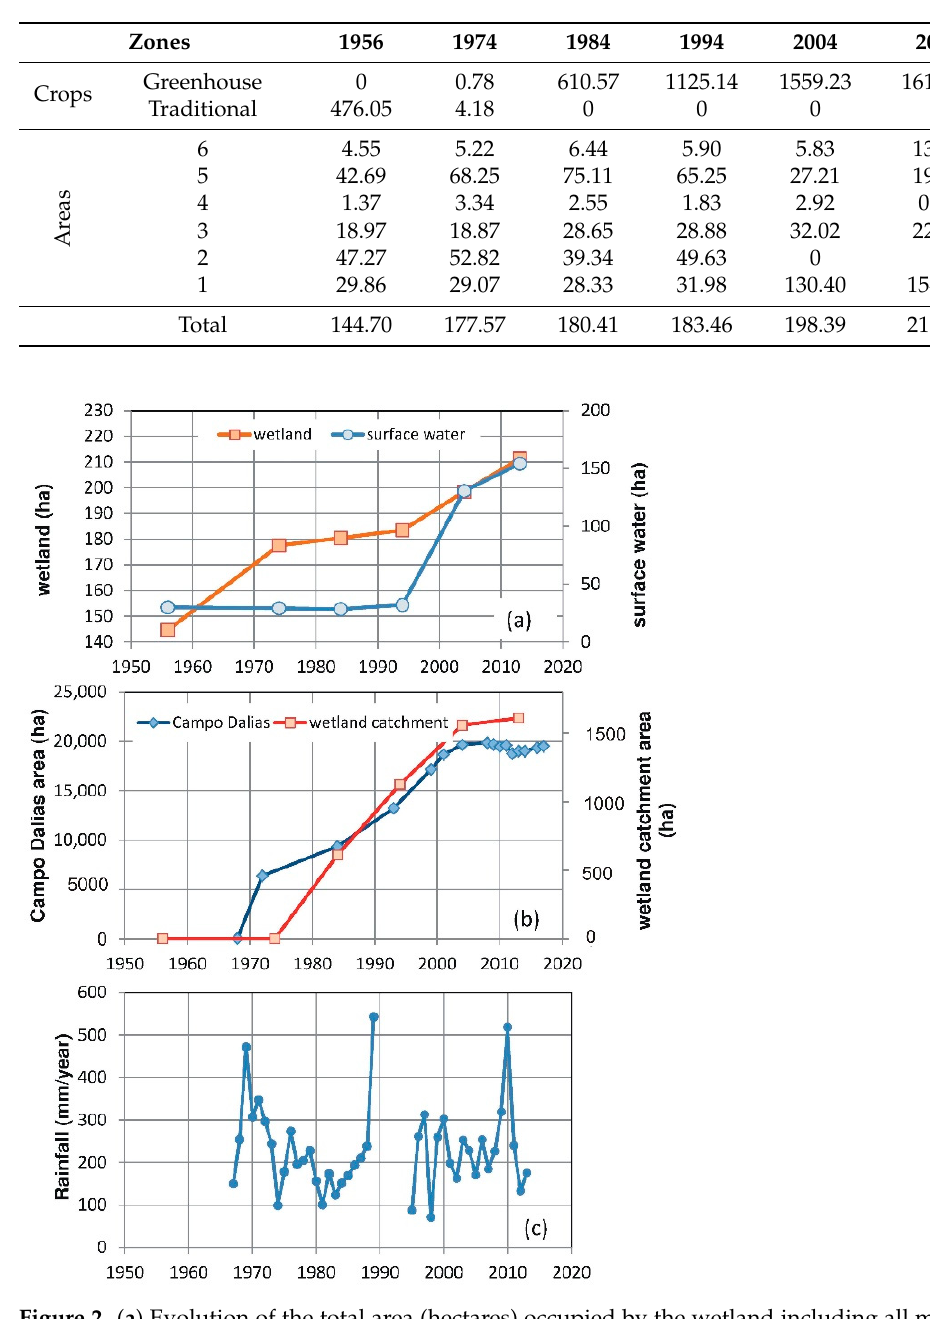
Table 3. Areas (hectares) defined by image processing, separating different environments. Modified from [28]. 1: Surface water; 2: floodable salt marsh; 3: reed-beds; 4: small islands; 5: salt marsh; 6: salt marsh with Sabinar-lentiscar.